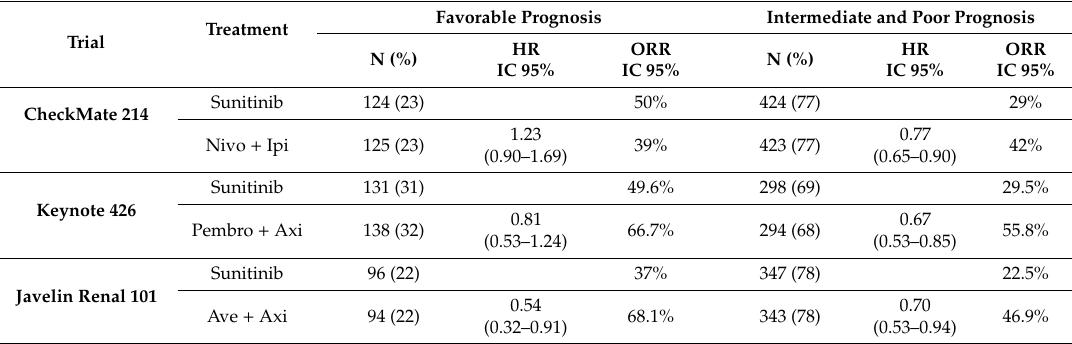
Table 2. Summary data in each IMDC